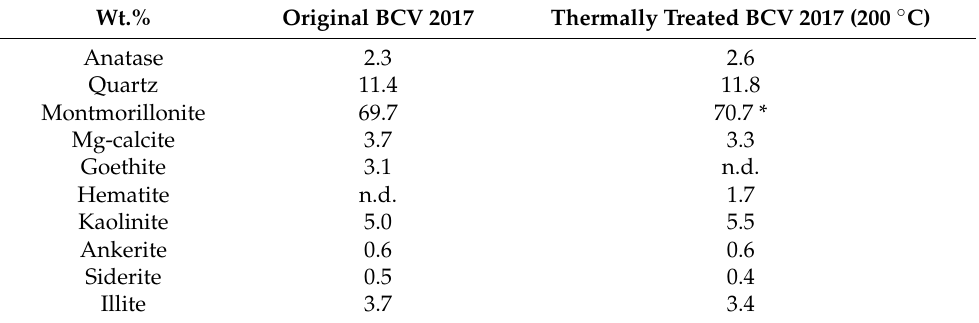
Table 2. Semiquantitative PXRD phase analysis of the original and the thermally treated BCV 2017 bentonite (in wt.%).